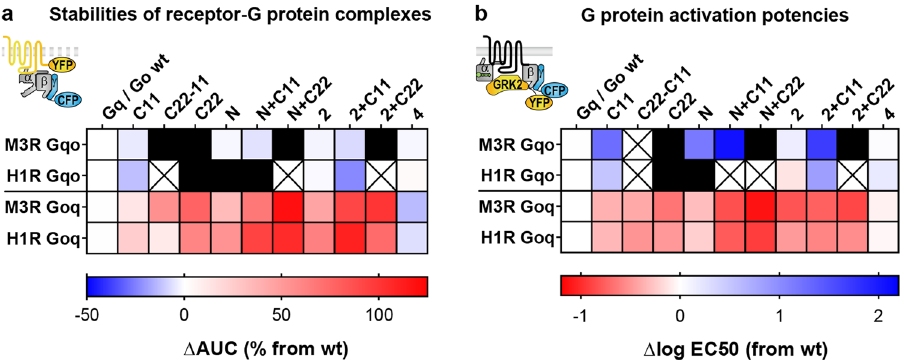
Fig. 6 Side-by-side comparison of coupling properties between M3R and H1R. a – b Summary of binding and activation experiments of chimeric G proteins measured in Figs. 1 – 5 is depicted side by side in heat maps. Rows describe investigated receptors and G protein classes from which the chimeric constructs originate. Columns represent segments where amino acids were replaced by the respective other G protein class. Their sites are illustrated in Fig. 3a, b. All data points are represented as means. Black areas indicate constructs showing no speci fi c signal over endogenous G proteins. Crossed areas mean that no data were acquired for that construct. a Colored areas show the Δ AUC relative to the native G protein depicted in red for a more stable or in blue for a less stable binding in receptor-G protein complexes compared to wild-type G proteins (white). b Tiles represent relative EC50 values of indirect G protein activation measurements shown in red for gains and in blue for losses of activation potency compared to wild-type G proteins